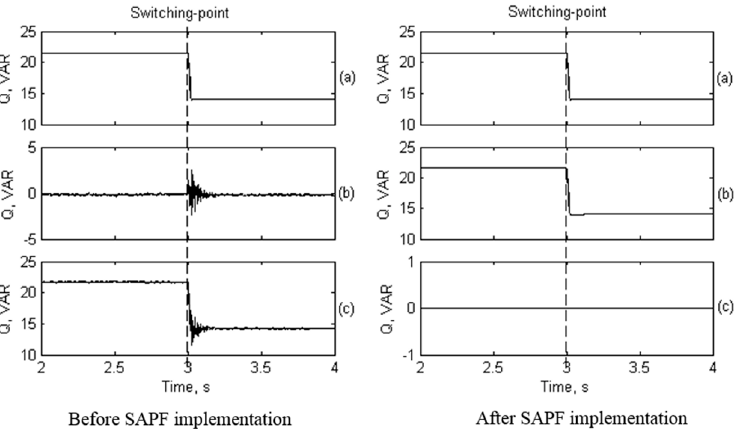
Figure 9. Reactive power consumed or generated by ( a ) both NLs, ( b ) main voltage supply and ( c ) SAPF during steady ‐ state and dynamic ‐ state operations